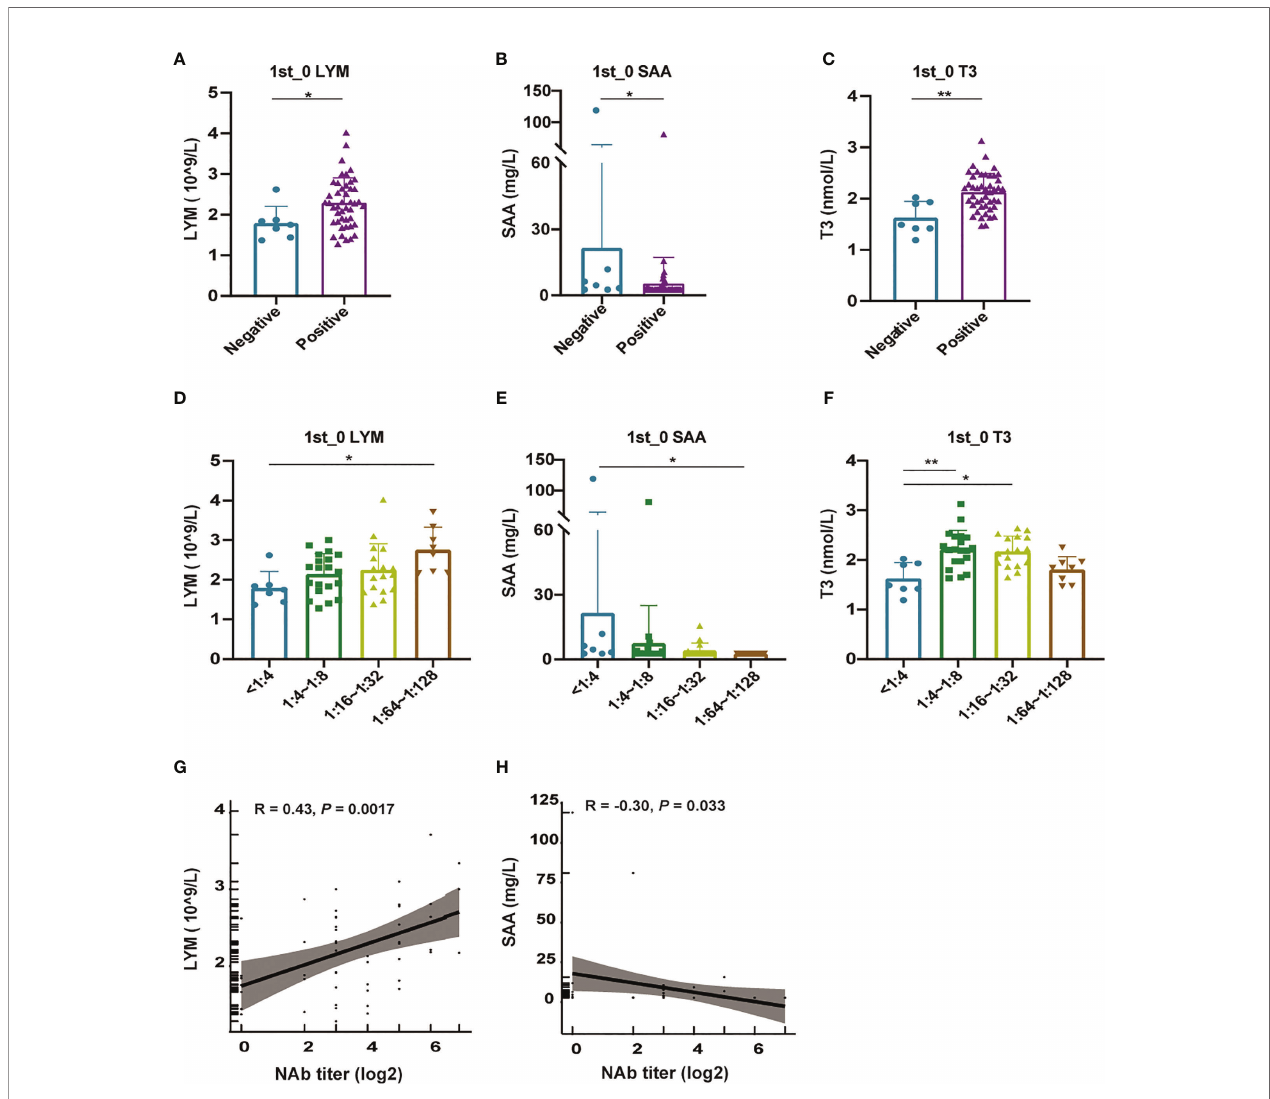
FIGURE 5 | The relationship between the levels of blood parameters and NAb titer levels. (A-C) , Comparison of prevaccine lymphocyte counts (A) , SAA (B) , T3 (C) between negative and positive recipients. (D – F) , Comparison of prevaccine lymphocyte counts (D) , SAA (E) , T3 (F) between recipients with different peak titer levels. (G) Correlation between the peak NAb titer and lymphocyte count levels. (H) Correlation between the peak NAb titer and the SAA levels. A nonparametric Kruskal- Wallis rank-sum method was employed to compare differences in multiple groups, and a nonparametric Mann-Whitney U test was applied to analyze differences between the two groups. Correlations were analyzed by Pearson correlation coef fi cients. Statistical signi fi cance of the difference between groups is denoted as * for P < 0.05, ** for P < 0.01. LYM, lymphocyte counts; SAA, serum amyloid A; T3, triiodothyronine; NAb, anti-SARS-CoV-2 neutralizing